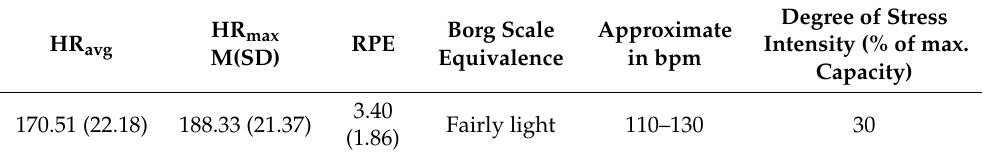
Table 6. Equivalence of the iTL variables compared to Buceta’s values [36].